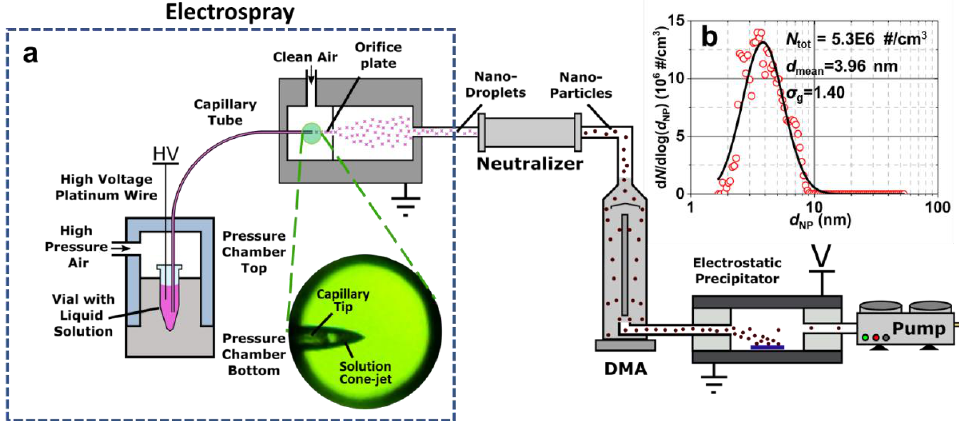
Figure 1. Experimental setup schematic for continuous W x Co y alloy nanoparticle generation, size selection, and collection. The mixed solution of W- and Co-based compounds was cone-jetted into nano-droplets by the electrospray aerosol generator ( a ), due to the high electric field between the solution cone and orifice plate. After the highly charged nano-droplets are neutralized and self-dried after passing through the neutralizer, W-Co salt nanoparticles form but with a polydisperse size distribution as characterized by a scanning mobility particle spectrometer ( b ) with diameter range within 1–10 nm, and geometric mean particle diameter ( d mean ) ~ 3.96 nm, geometric standard deviations ( σ g ) ~ 1.4, and concentration ( N tot ) of 5.3 × 10 6 #/cm 3 . They are further size-selected by a di ff